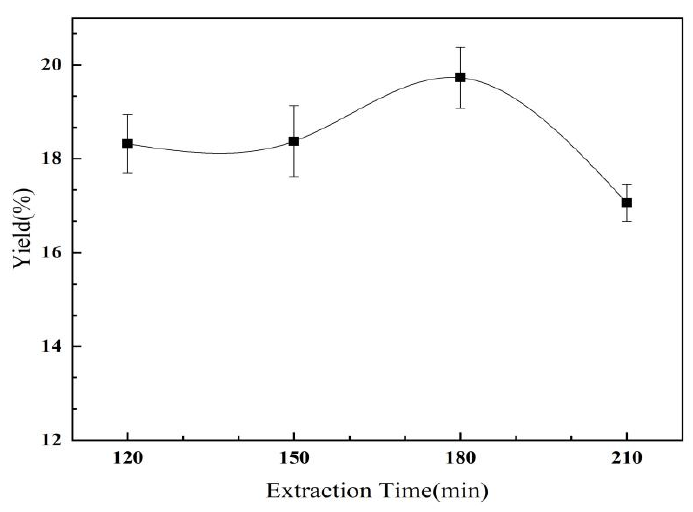
Figure 7. Influence of extraction time on yield of C. oleifera saponins (liquid–solid ratio = 3.5:1; extraction temperature = 65 ◦ C; methanol concentration = 75%).